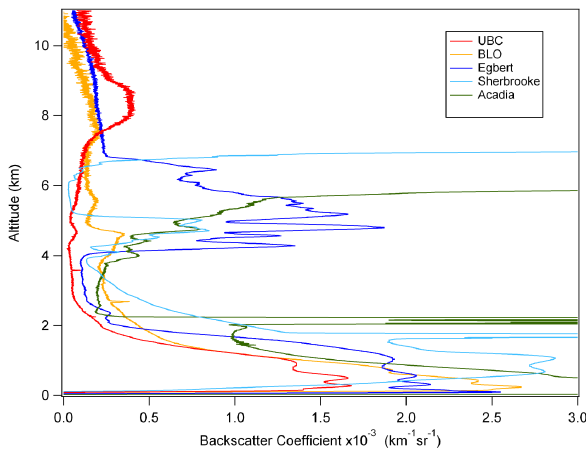
Fig. 11. Lidar profile data averaged over the plume duration at all five CORALNet lidar